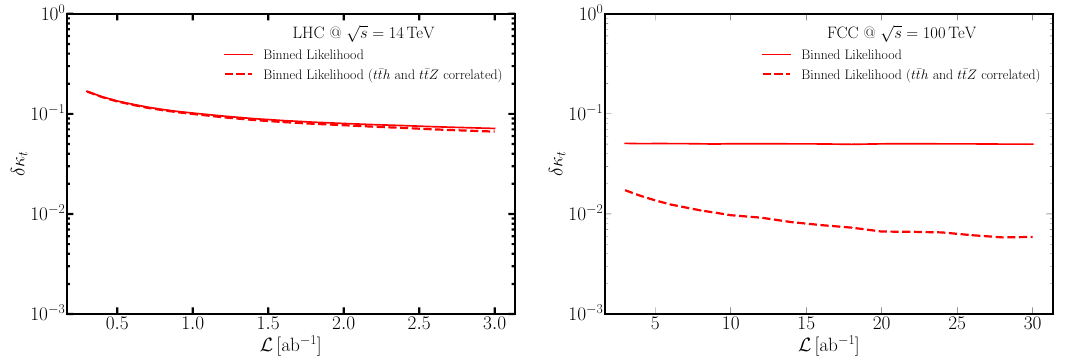
√ √ s = 14 TeV (left) and s = 100 TeV (right),